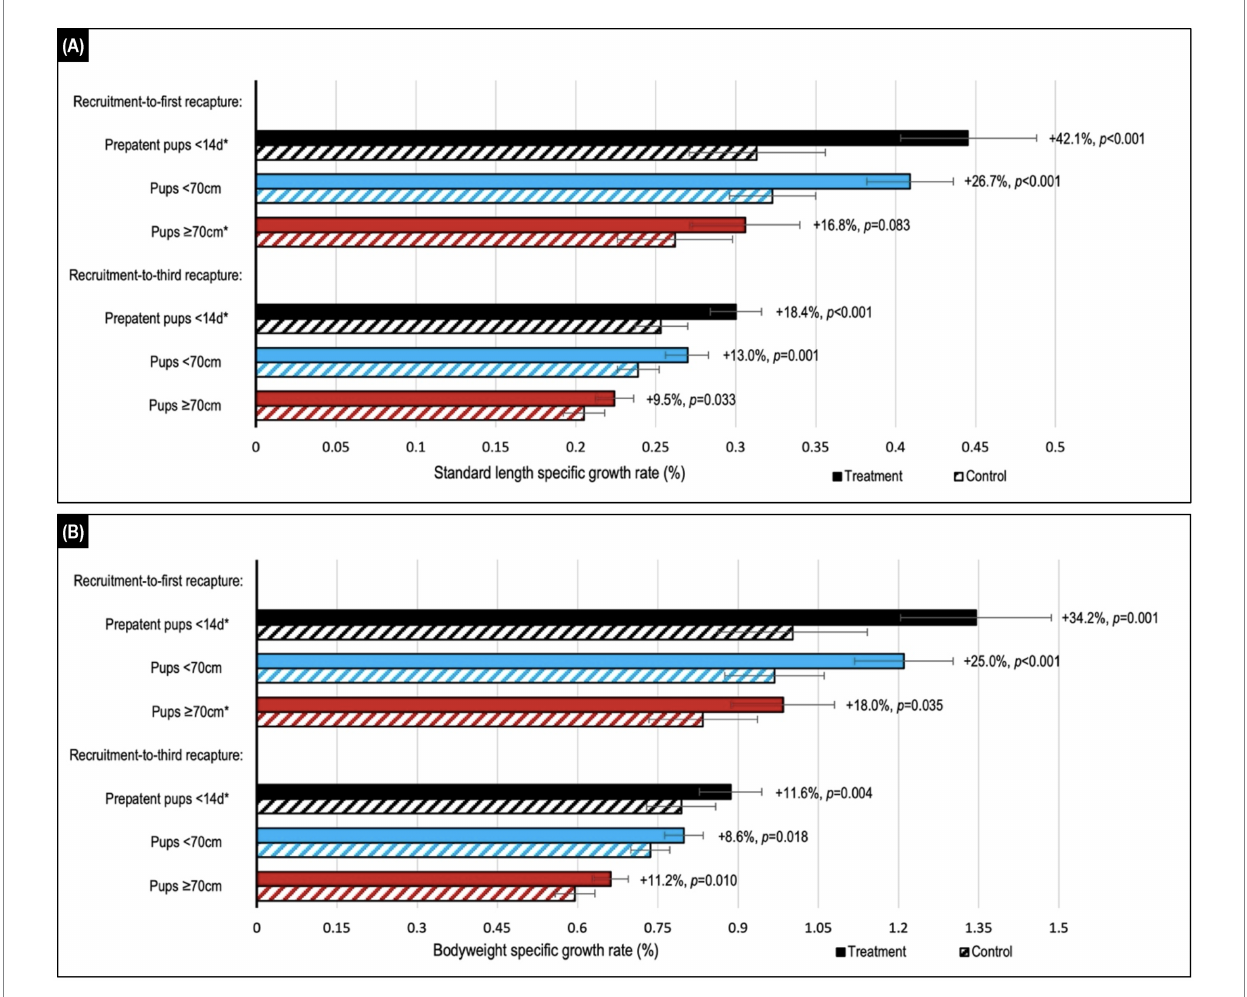
FIGURE 3 Comparison of estimated median values for (A) standard length and (B) bodyweight daily specific growth rates (SGRs) in Australian sea lion pups after either topical ivermectin application and early hookworm elimination (treated), or no treatment (control). Treatment effect (calculated as the relative difference in daily SGR between treatment and control groups) and p -value are shown to the right of the treatment bars. Stratification by age showed the highest relative benefits in the youngest <14d age cohort of prepatent pups. Assessment across the recruitment-to-first recapture (median 31 d, range: 15–111 d) and recruitment-to-third recapture (median 95 d, range: 76–195 d) periods showed the greatest benefits in the month immediately after treatment and persistence of benefits to 3 months post-treatment for all age cohorts. Daily SGRs were calculated as the natural log of each morphometric at the start of the period, minus that at the end of the period, divided by period length in days. Error bars indicate the estimated 95% confidence intervals. *A significant interaction between treatment and follow-up period length in days was apparent, therefore estimates are reported for the daily SGR at the median length of the follow-up